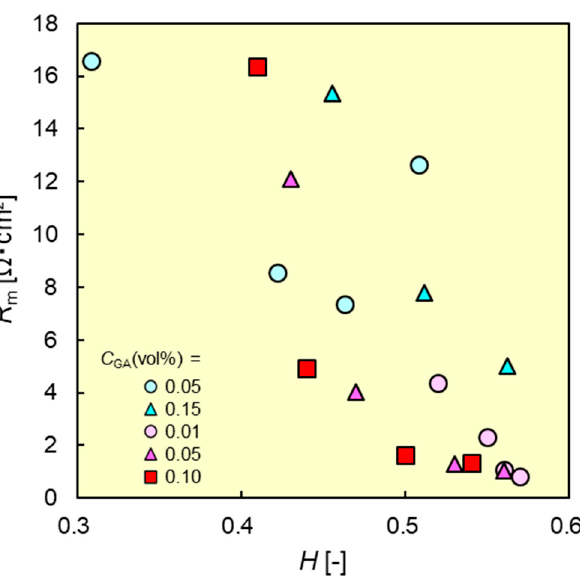
Figure 7. Membrane resistances R m of B-CEMs and R-CEMs as functions of water content H . Red and blue symbols denote the data of B-CEMs and R-CEMs,